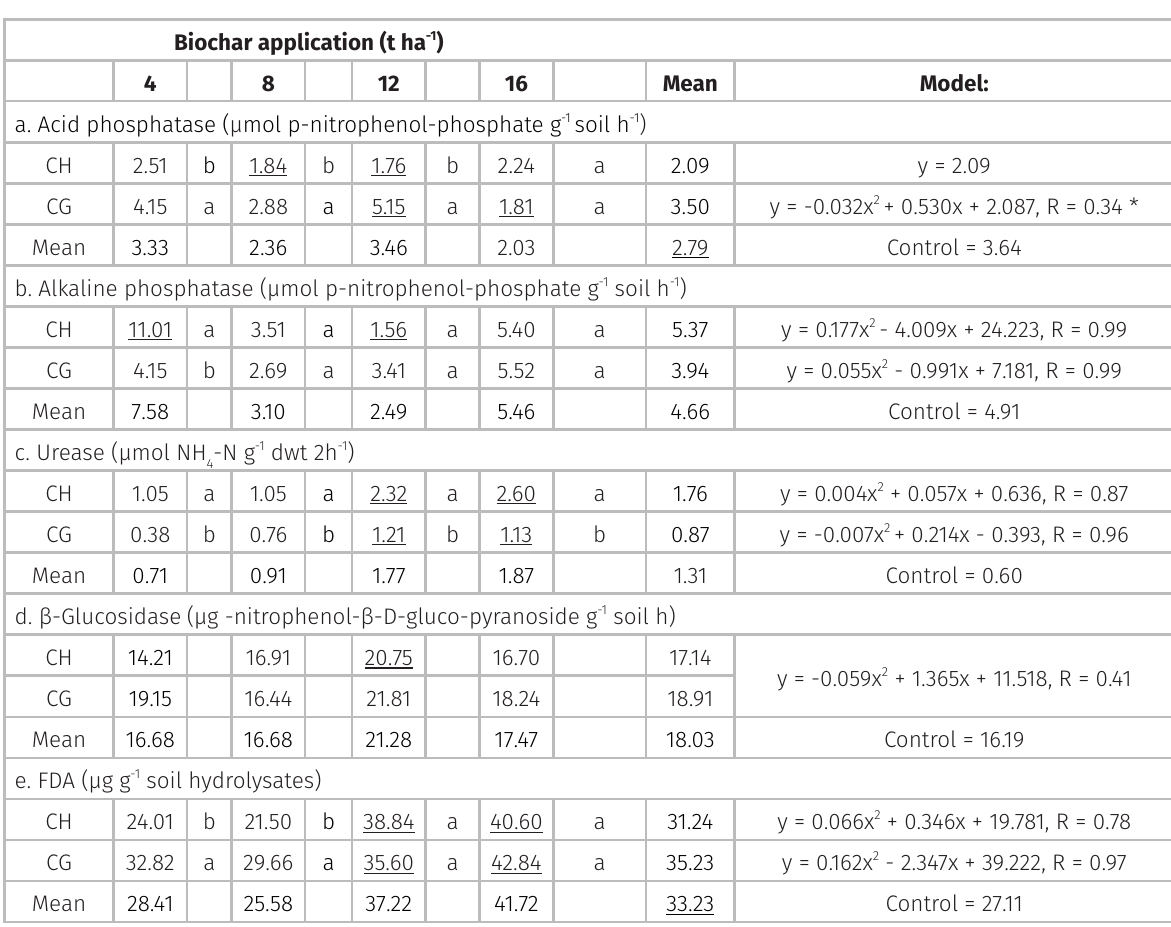
Table IV. Enzymatic activities of sandy Entisol treated with biochar produced from the coffee ground (CG) and coffee husk (CH) residues, cultivated with the bean plant in Northeastern